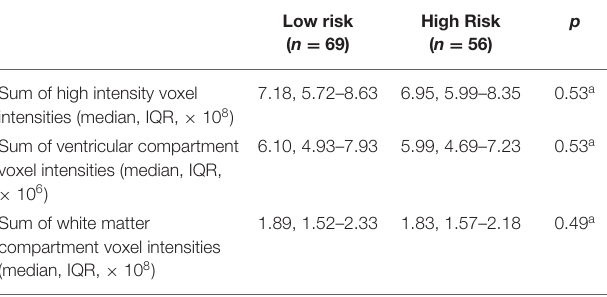
TABLE 2 | Estimates of background PET